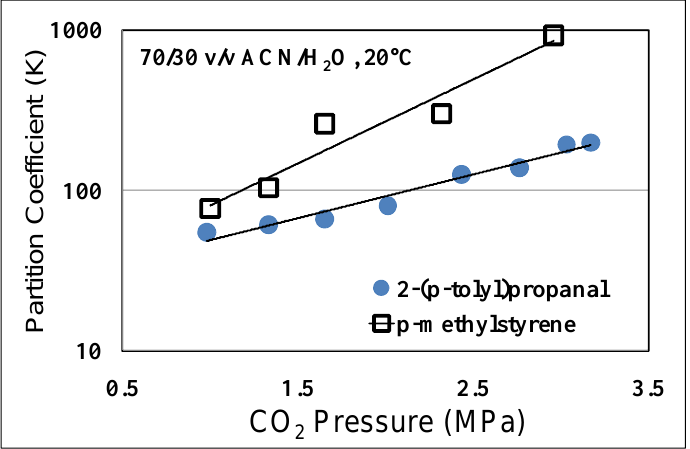
Figure 7. Partitioning of hydroformylation reaction substrates in the organic-rich phase as